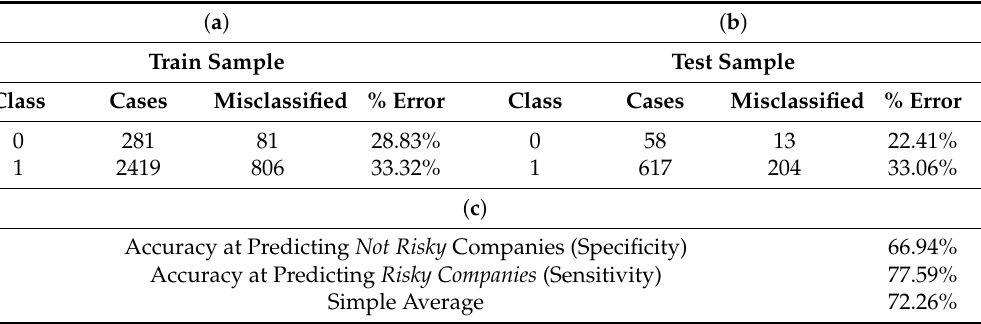
Table 7. ( a ) RF-train sample; ( b ) RF-test sample; ( c ) RF model accuracy (test